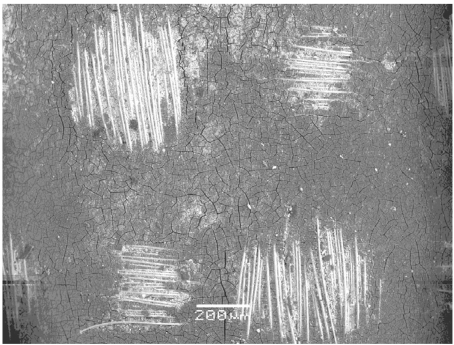
Figure 10. SEM image of the textolite material surface with visible degradation effects (75 times magnification). In addition to the light bundles of fibres of the textile support, there was clear cracking of the top layer of resin.